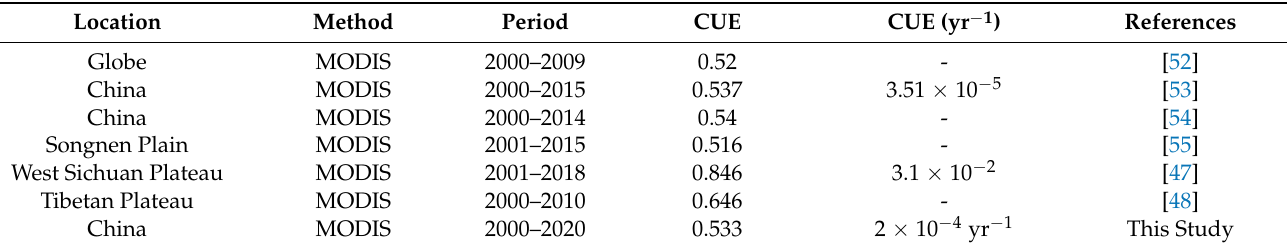
Table 3. Mean values and trends of CUE by region.